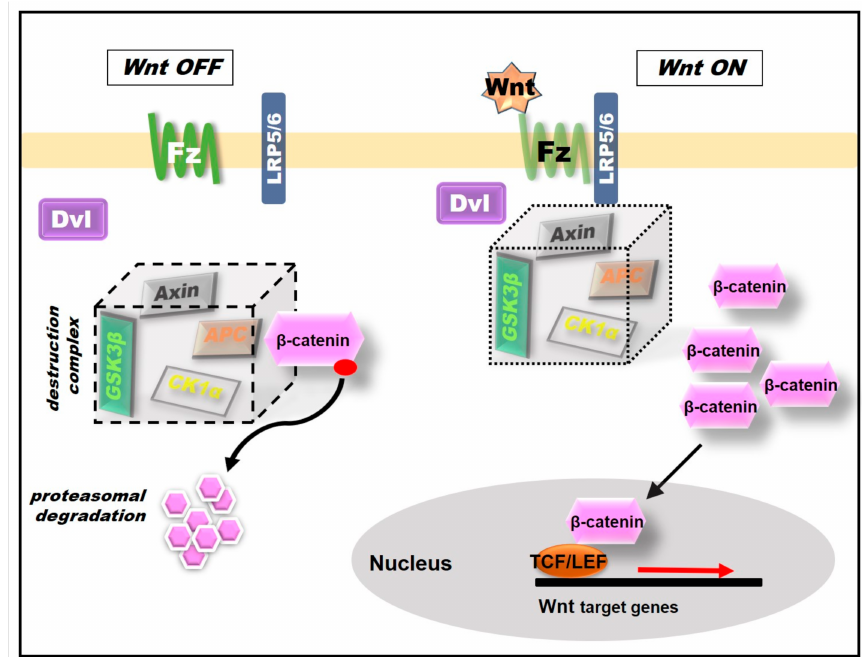
Figure 1. Overview of Wnt / β -catenin pathway. In the absence of Wnt stimulation (Wnt OFF), cytoplasmic levels of β -catenin are low since it is phosphorylated by the destruction complex, resulting in recognition and proteasomal degradation. Once the Wnt-Fz-LRP5 / 6 interaction (Wnt ON) has started, the destruction complex is disassembled and therefore the proteasomal degradation of β -catenin is prevented. In this way, β -catenin accumulates within the cytoplasm and translocates to the nucleus, where it binds to the transcription factors (T-cell factor and lymphoid enhancer factor (TCF / LEF)) to finally activate the transcription of Wnt target genes. LRP5 / 6, lipoprotein receptor-related protein 5 or 6; Fzd, receptor frizzled; Dvl, dishevelled; APC, adenomatous polyposis coli; CK1 α , casein kinase 1 α ; GSK3 β , glycogen synthase kinase 3 β